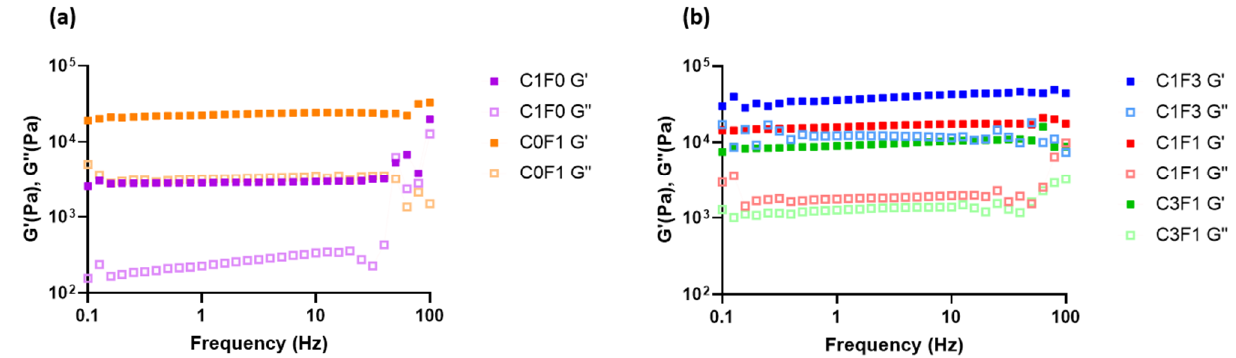
Figure 7. The rheological measurements of the fabricated hydrogel composites represented in loss modulus G″ and storage modulus G′ with respect to frequency for samples C1F0 and C0F1 ( a ) and C1F3, C1F1, and C3F1 ( b ).